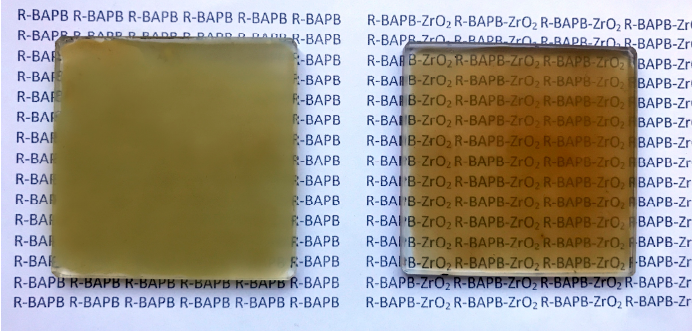
Figure 2. Optical images of pristine R-BAPB ( left ) and composite membrane R-BAPB-ZrO 2 ( right ).